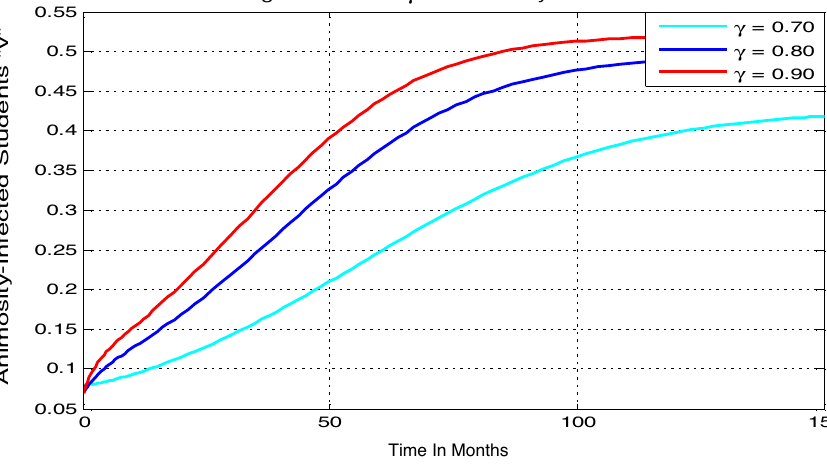
Figure 5. Effect of progression rate γ on Animosity-infected students.